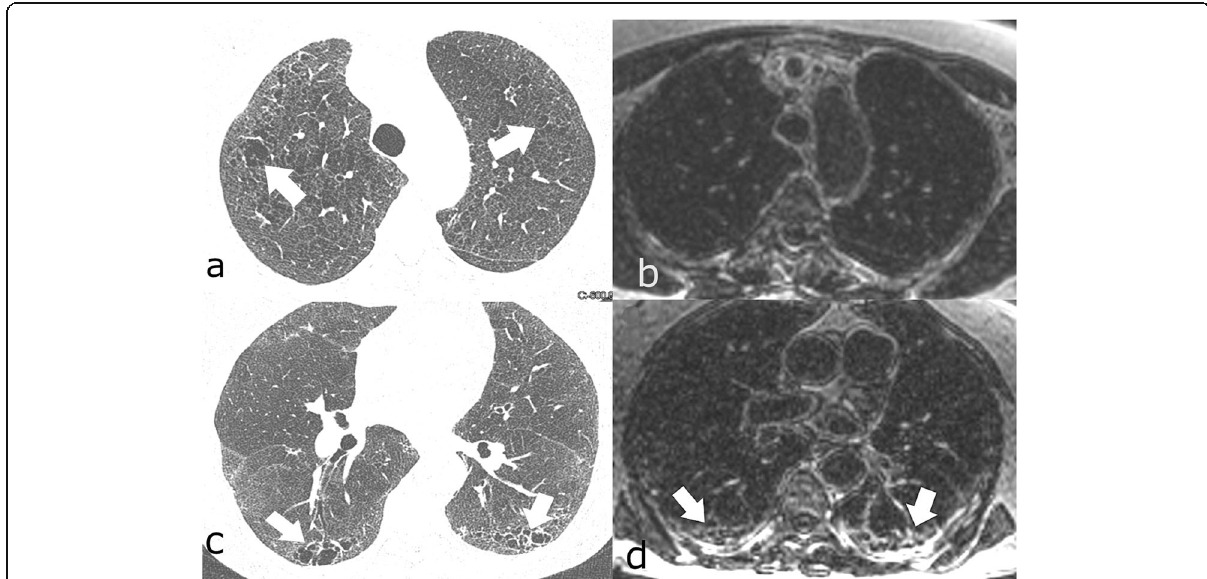
Fig. 2 Seventy-two-year-old woman with progressive breathlessness, FEV 1 2.4 L/s, LAV 1.5%. a Axial high-resolution computed tomography showed mild centrilobular emphysema in the upper lobes (arrows). b It was unclear at multidisciplinary conference whether the abnormal regions in the lower lobes (arrows) represented emphysema or fibrosis. c Late gadolinium-enhanced magnetic resonance imaging of the upper lobes showed no contrast enhancement, but in d , definite contrast enhancement was observed in the abnormal regions in the lower lobes (arrows) and was consistent with fibrosis. FEV 1 , Forced expiratory volume in one second; LAV% , Low attenuation value percent